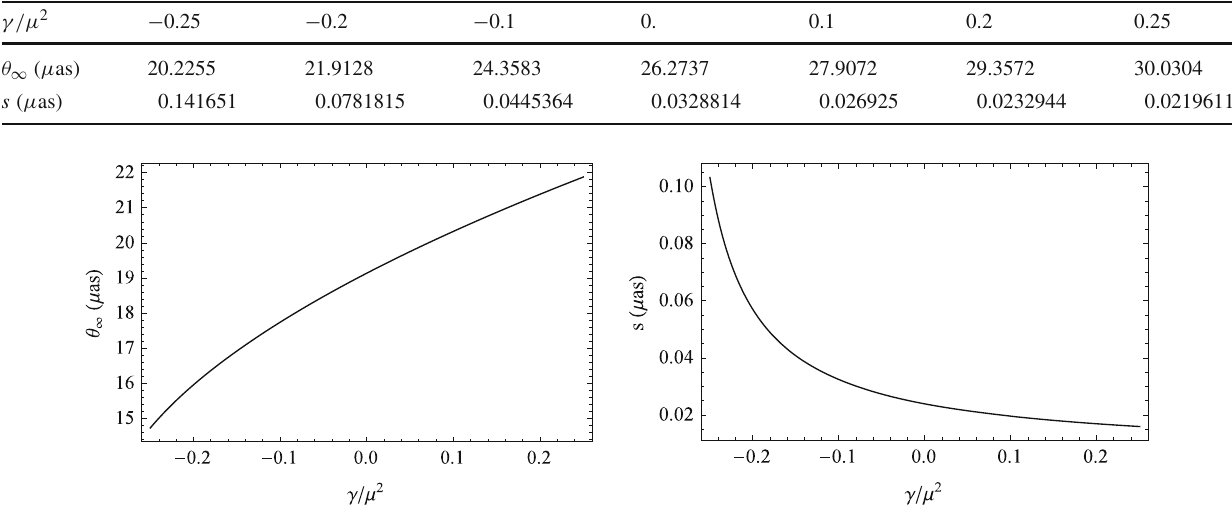
Fig. 3 Limiting location of the images θ ∞ (left) and angular separation s between the first image and the limiting value (right), as functions of γ/μ 2 for the supermassive black hole in the Milky Way Table 2 Numerical values of the observables θ ∞ and s for various values of γ/μ 2 for the supermassive black hole in the Milky Way